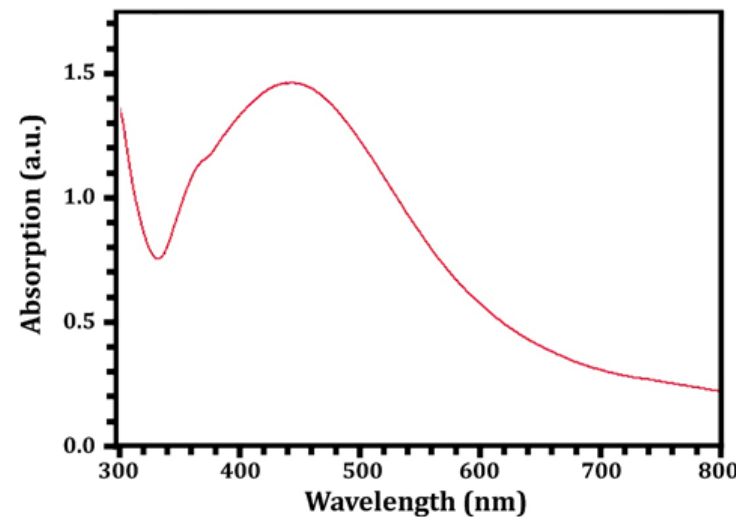
Figure 3. UV-Vis spectra of the Streptomyces rochei MS-37-derived SNPs.